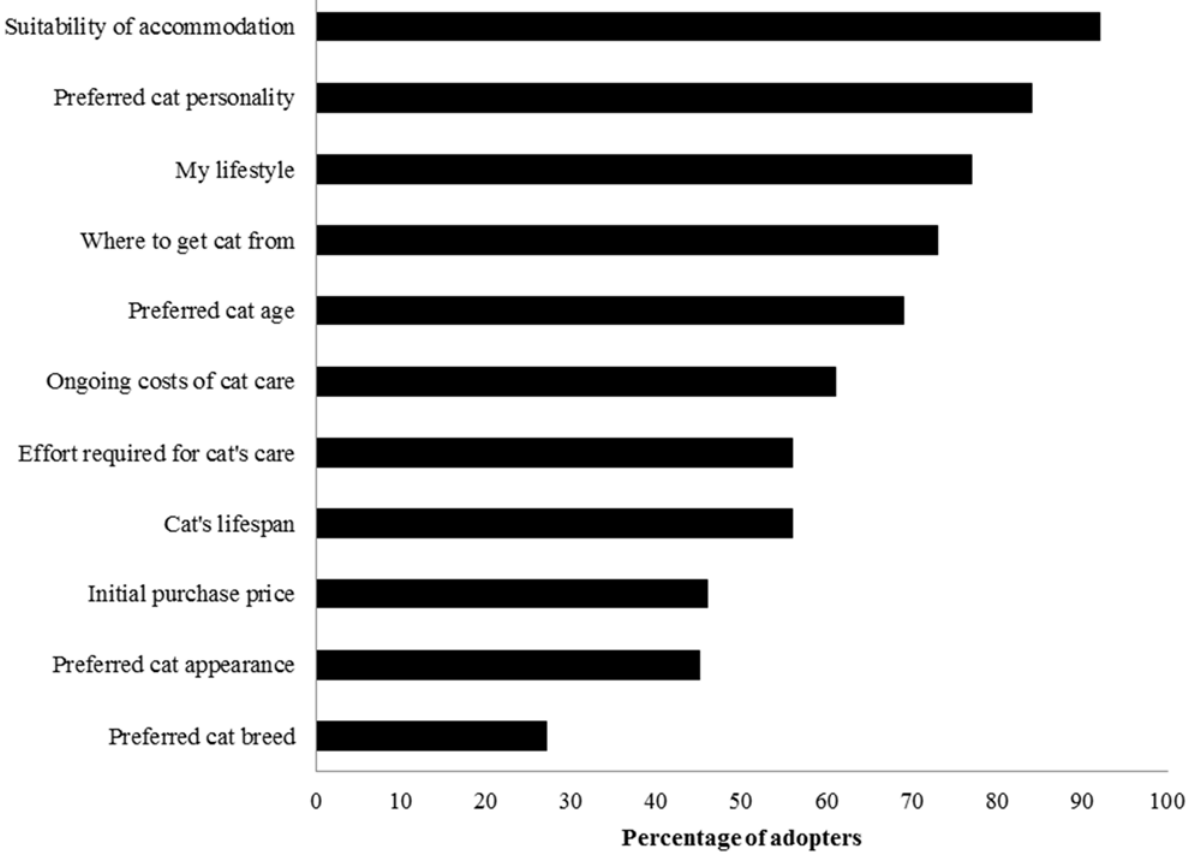
Figure 1. Factors considered by adopters before adopting their study cat(s). Between